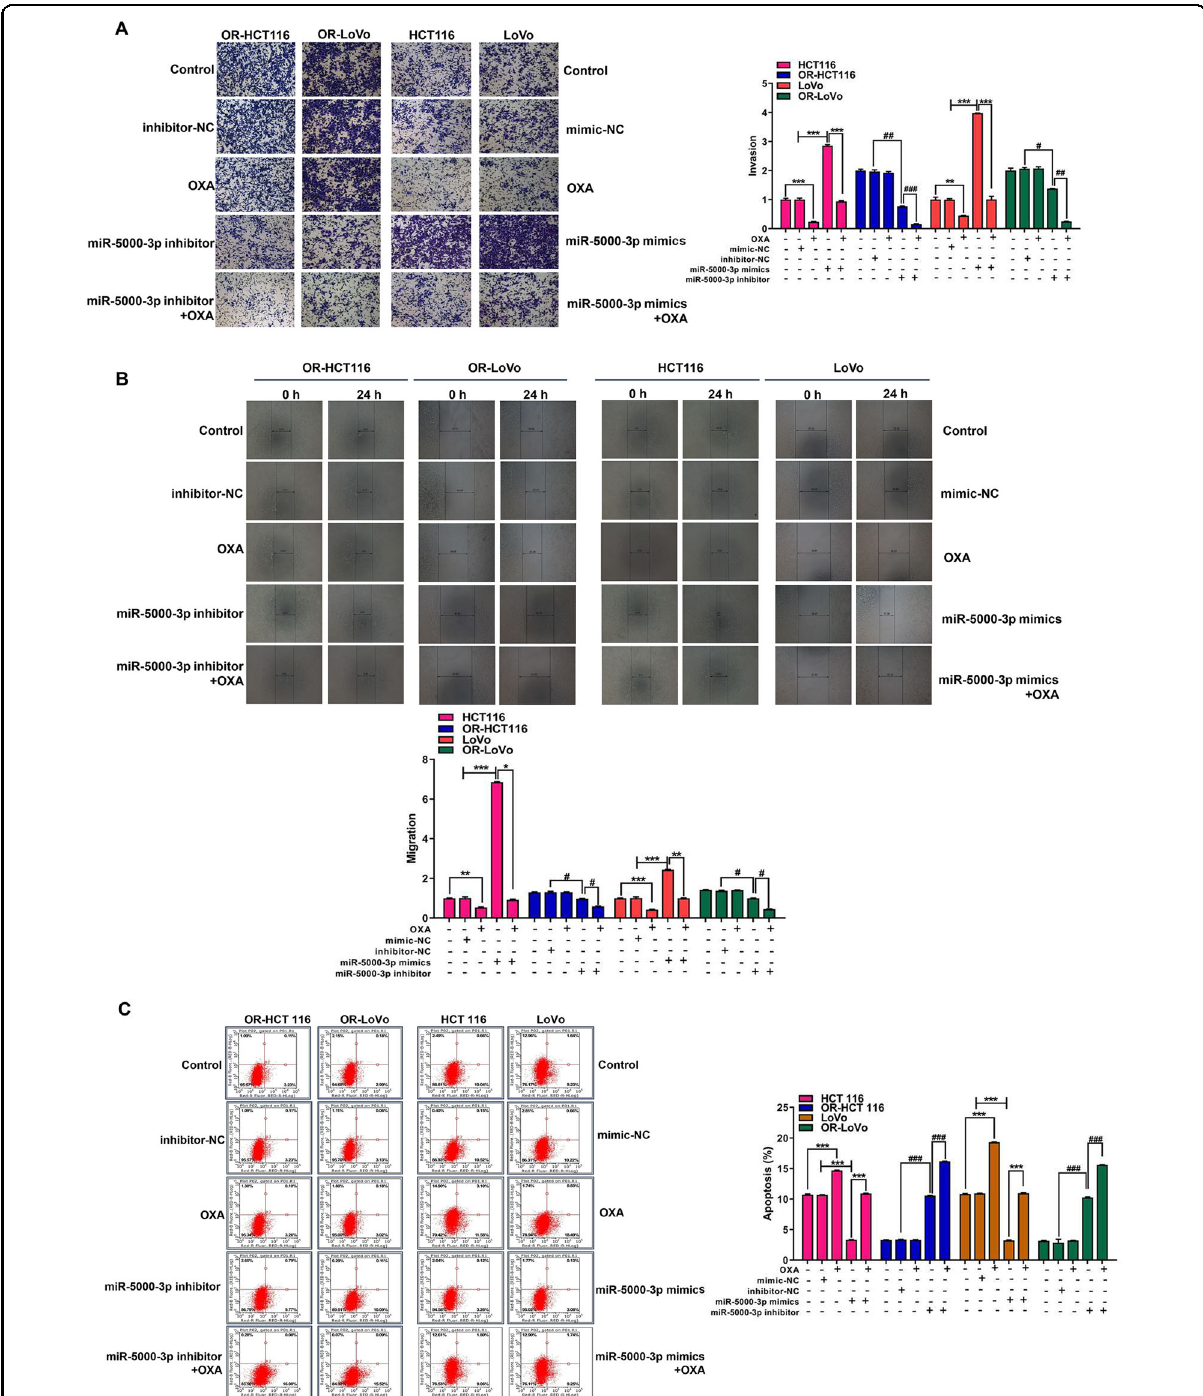
Fig. 3 The effect of the overexpression or knockdown of miR-5000-3p and treatment with or without OXA on cell invasion, migration, and apoptosis of HCT116 and LoVo or OR-HCT116 and OR-LoVo cells in vitro. A Representative images and bar graphs showing the effects of miR- 5000-3p overexpression or knockdown on cell invasion of HCT116 and LoVo or OR-HCT116 and OR-LoVo cells. B Effects of miR-5000-3p overexpression or knockdown on cell invasion of HCT116 and LoVo or OR-HCT116 and OR-LoVo cells were measured by wound-healing assays. C Effects of miR-5000-3p overexpression or knockdown on cell apoptosis of HCT116 and LoVo or OR-HCT116 and OR-LoVo cells were measured by fl ow cytometer assays. * p < 0.05, ** p < 0.01, and *** p < 0.001; # p < 0.05, ## p < 0.01, and ### p <